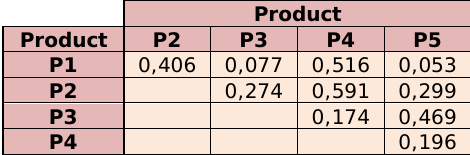
Table 3. Similarity coefficients for each pair of